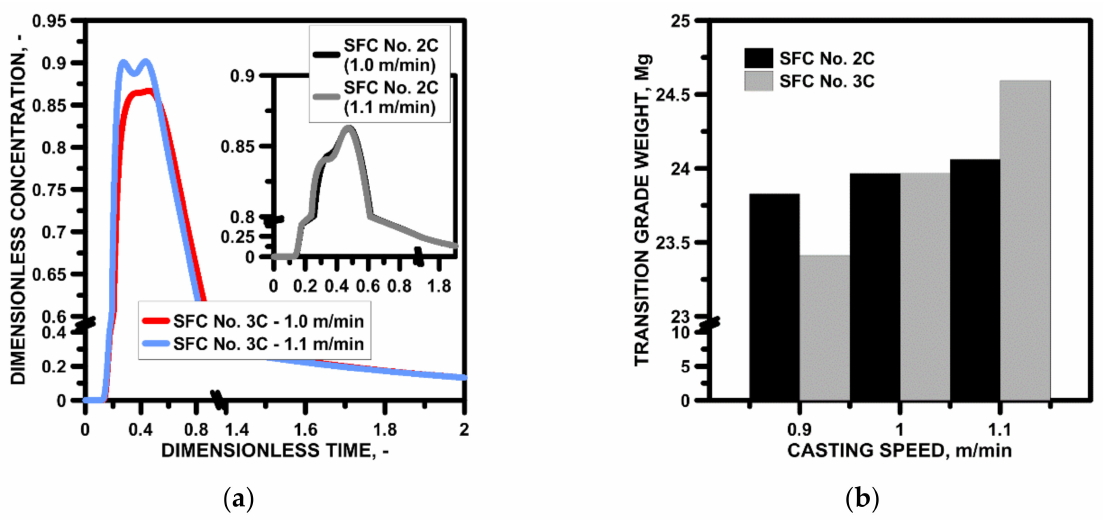
Figure 15. Casting speed: ( a ) influence on stagnant and active flow, ( b ) influence on transition